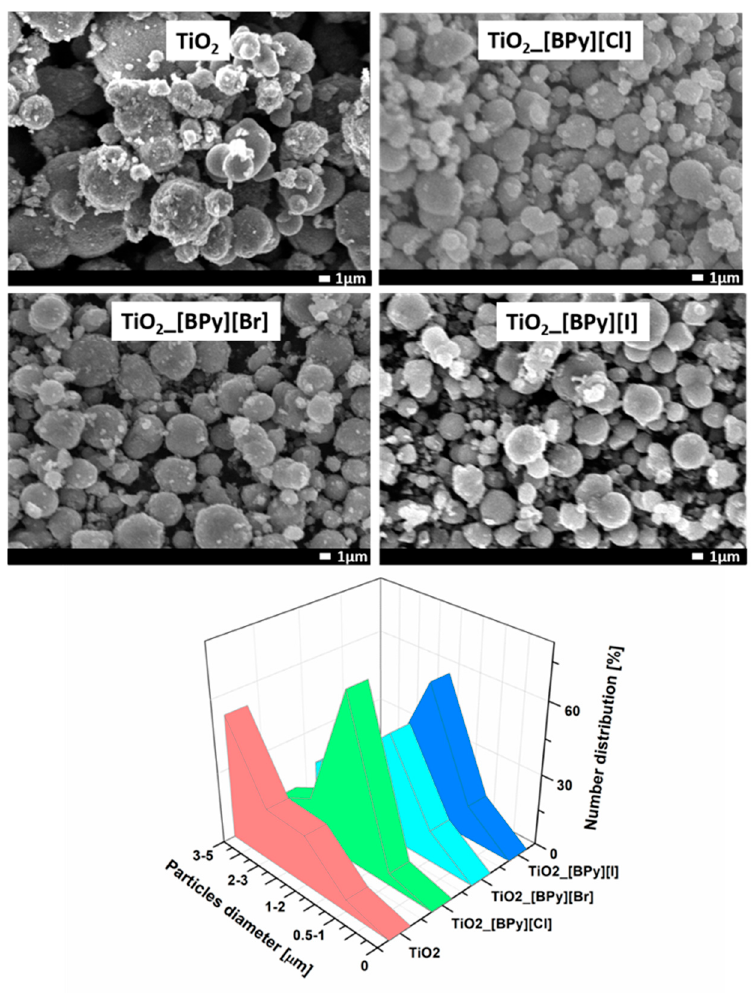
Figure 3. SEM images and particle size distribution of TiO 2 obtained by solvothermal process: without IL, with [BPy][Cl], [BPy][Br] and [BPy][I] ionic liquids.